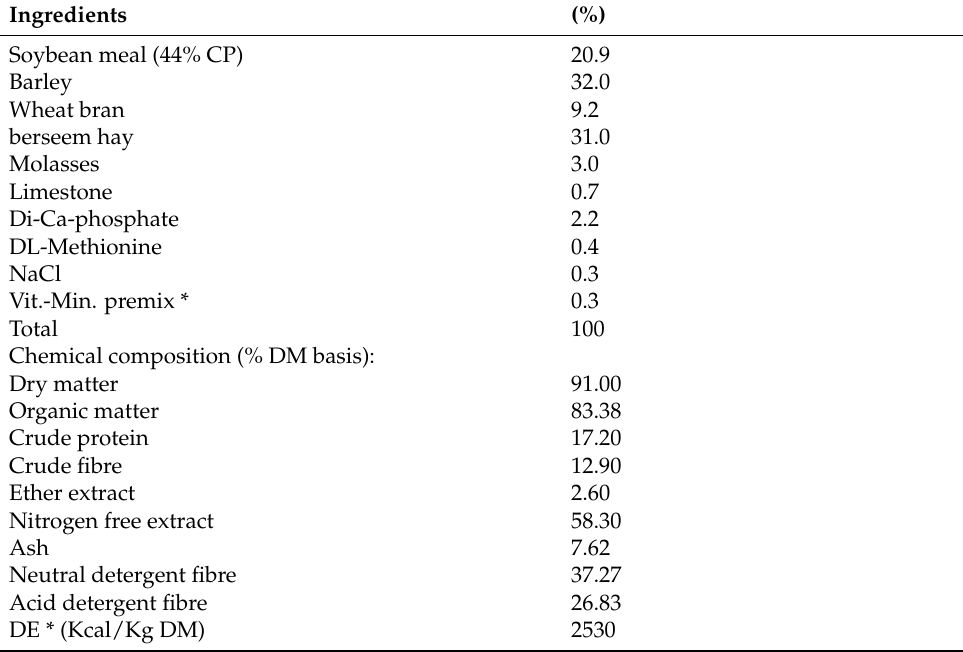
Table 1. Ingredients and chemical composition of the experimental diet (% DM